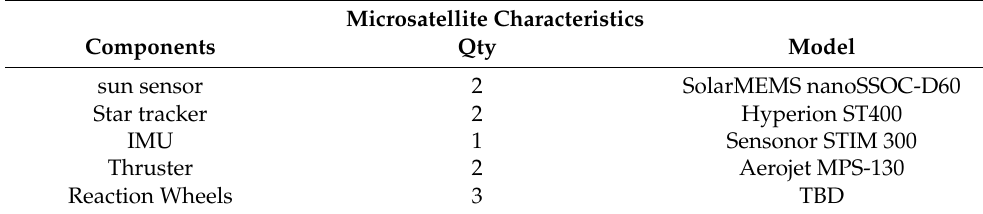
Table 1. LOCI’s ADCS items list.